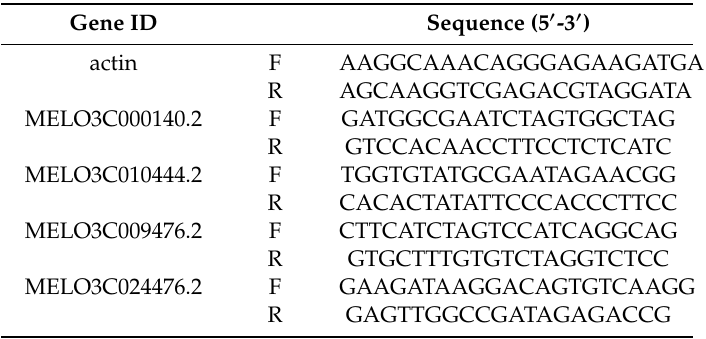
Table 4. QPCR primer sequences used to validate the RNA-seq